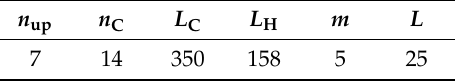
Table 4. Key parameters used for implementing LPFBS algorithm. Please see Reference [31] for detailed explanation and definition of symbols.